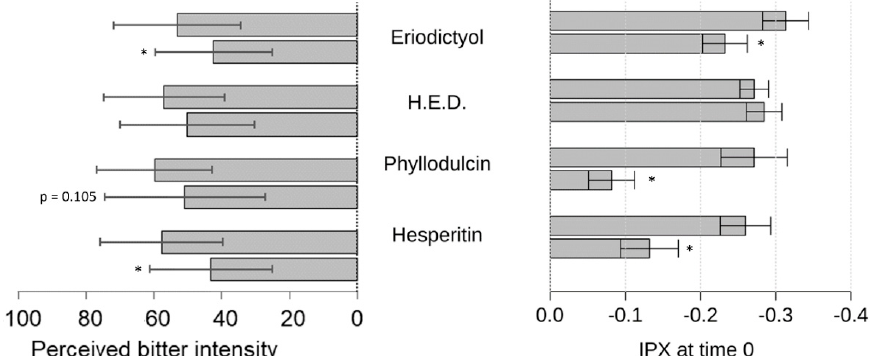
Figure 10. Modulating effect of eriodictyol, homoeriodictyol, phyllodulcin and hesperitin on guaifenesin bitterness and guaifenesin-induced changes in IPX index. (left) Guaifenesin 20 mg/15 mL (1333 ppm, 6.73 mM) was administered in combination with several bitter-masking compounds (eriodictyol (100 ppm), homoeriodictyol (100 ppm), phyllodulcin (7 ppm) and hesperitin (100 ppm)) and their mixtures to a panel of 25–31 trained volunteers. (right) IPX index of HGT-1 cells at the beginning of a 30-minute measurement. Cells were exposed to 10 mM guaifenesin either alone or in combination with the indicated bitter-masking compound (eriodictyol (30 ppm), homoeriodictyol (30 ppm), phyllodulcin (30 ppm) and hesperitin (30 ppm). N of 3–5 biological replicates. All data presented as mean +/ − sem. Statistical significance was evaluated using one-way ANOVA with Tukey’s range test for multiple comparisons. * denotes p < 0.05 for the corresponding compound when compared to the effect of guaifenesin.